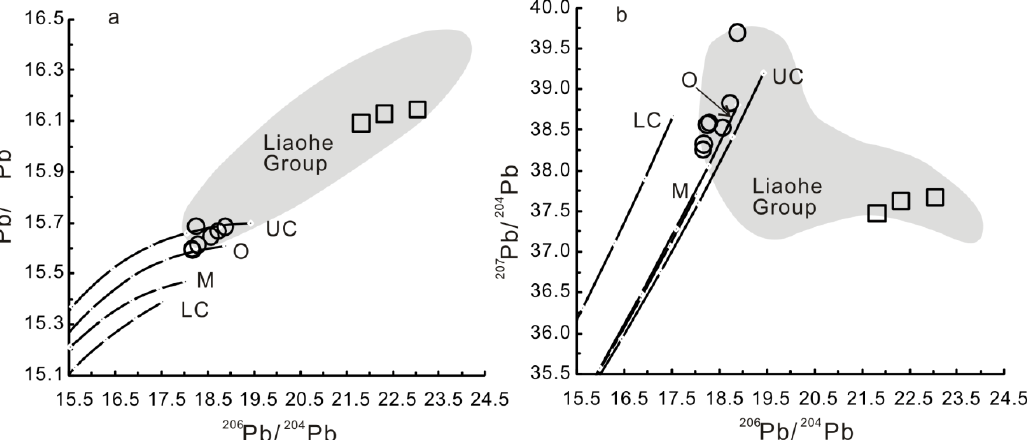
Figure 6. Lead isotope ratio from ore-bearing pyrite and marble from the Lijiapuzi deposit. Data of the Liaohe Group. ( a ) 208 Pb/ 204 Pb vs. 206 Pb/ 204 Pb; and ( b ) 207 Pb/ 204 Pb vs. 206 Pb/ 204 Pb. (Gaixian and Dashiqiao formations) are from [6]. Table 3. Lead isotope ratios of ore-bearing pyrites and marbles from the Lijiapuzi gold deposit.